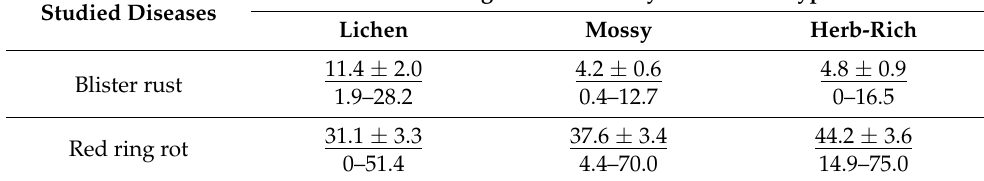
Table 2. The incidence in pine forests, % (numerator—mean ± standard deviation; denominator— extreme